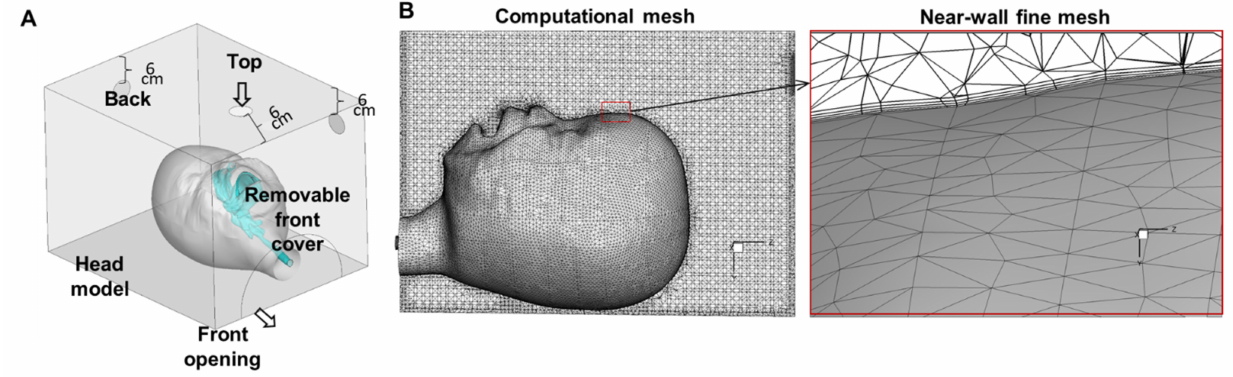
Figure 1. Computational model for drug delivery to a seven-month-old model using a hood: a face- mouth-nose-throat geometry placed in a hood with a removable front cover ( A ); fine computational mesh with five layers of near-wall prismatic mesh ( B